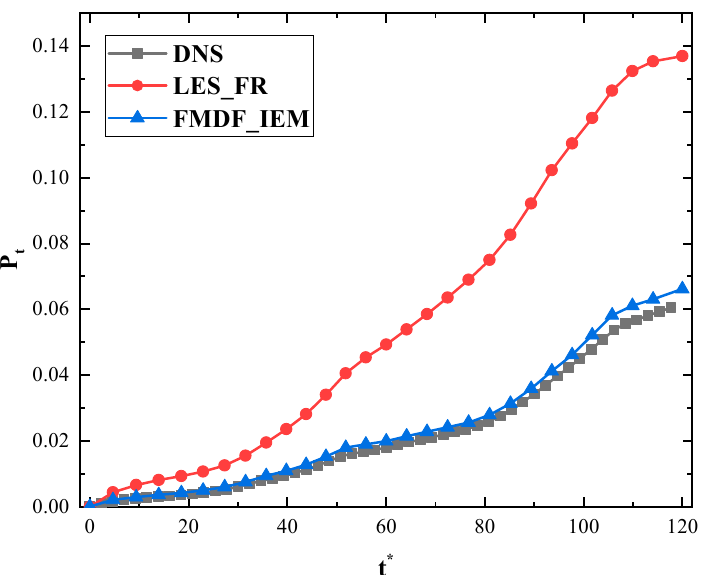
Figure 3. Mean of the total product mass fraction versus dimensionless time of DNS, LES, and FMDF when M c = 0.8.